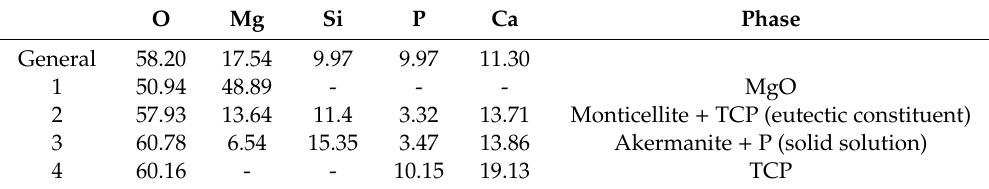
Figure 4. SEM image of a directionally solidified rod grown at 100 mm/h. Table 4. EDS analysis (atom %) for directionally solidified rods at 100 mm/h.